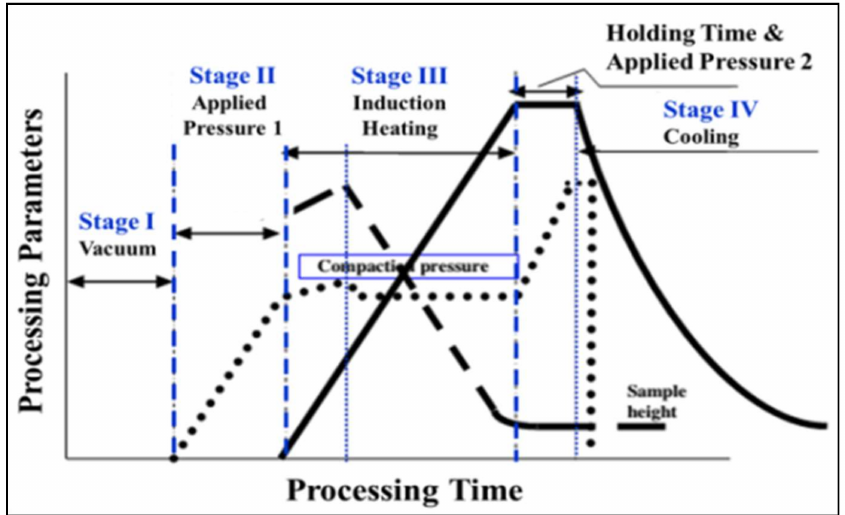
Figure 2. The four sequential stages of sintering in high frequency induction heat sintering (HFIHS) process [22]. (© 2012, Elsevier. Used with